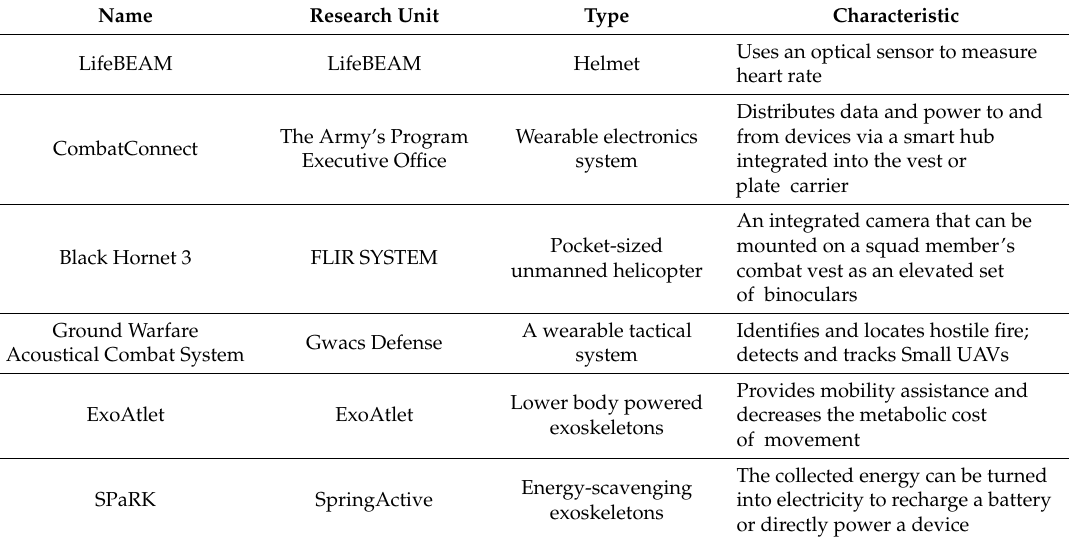
Table 1. Existing research achievements on wearable devices for